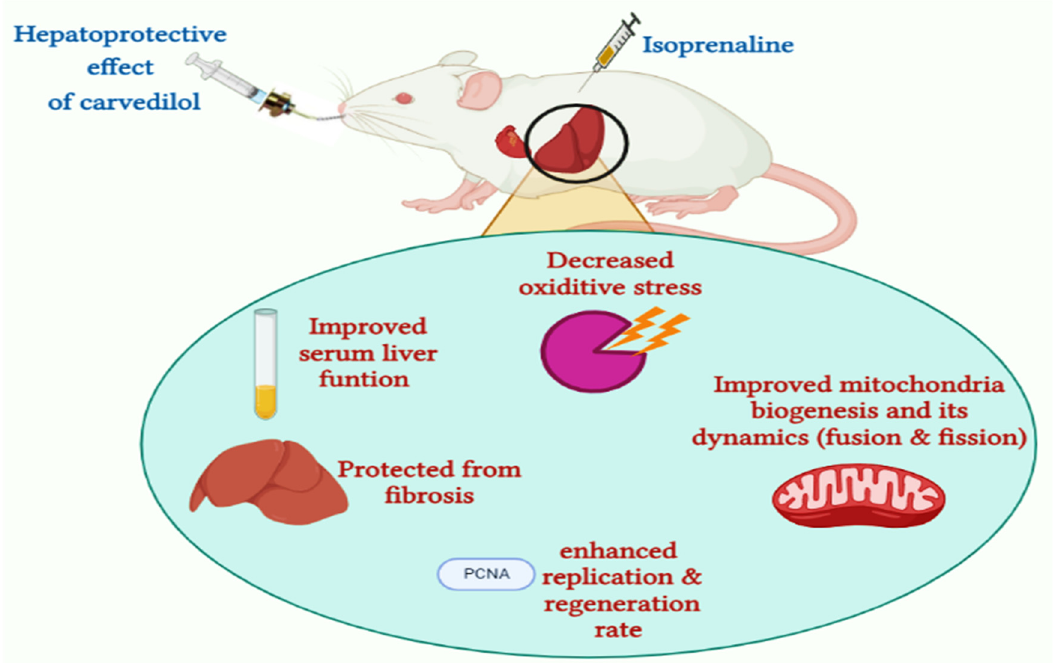
Figure 15. Hepatoprotective effect of carvedilol in ischemic hepatitis associated with acute heart